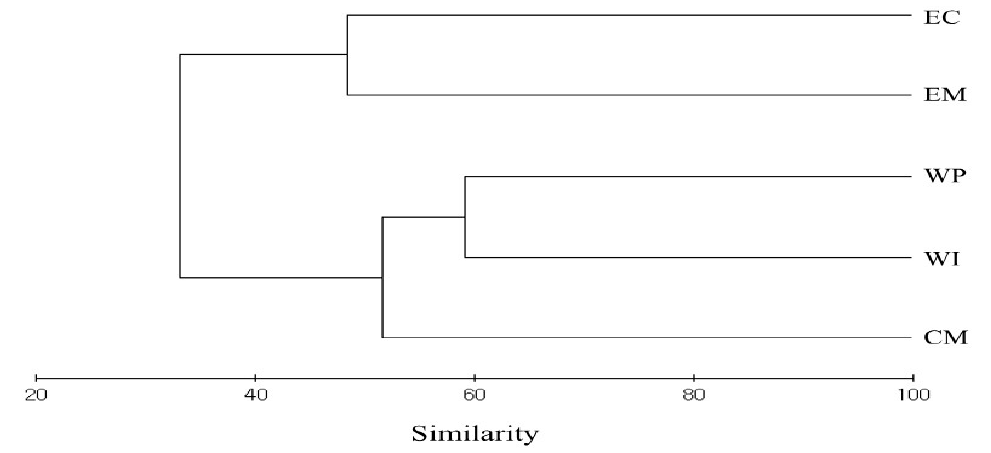
Figure 3. Dendrogram produced from a hierarchical cluster analysis of species composition in the five regions of the adjacent areas of the DMZ. Study region codes are the same as those defined in Table